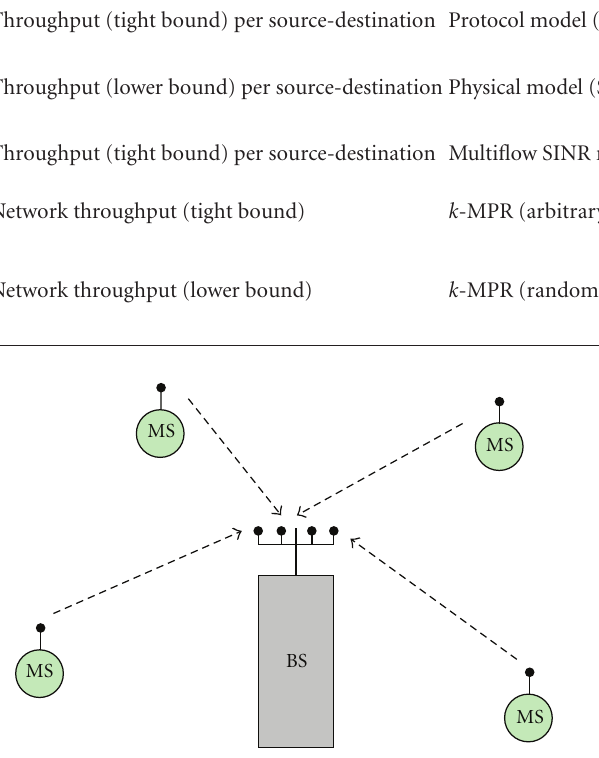
Figure 2: The BS is MPR in a MIMO system with multiple